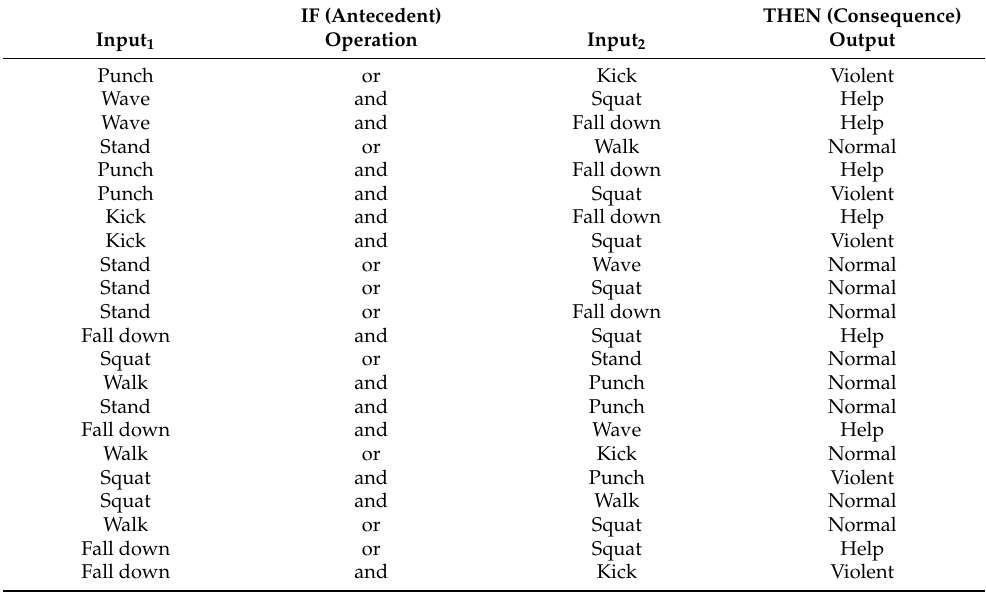
Table 1. The rules of fuzzy